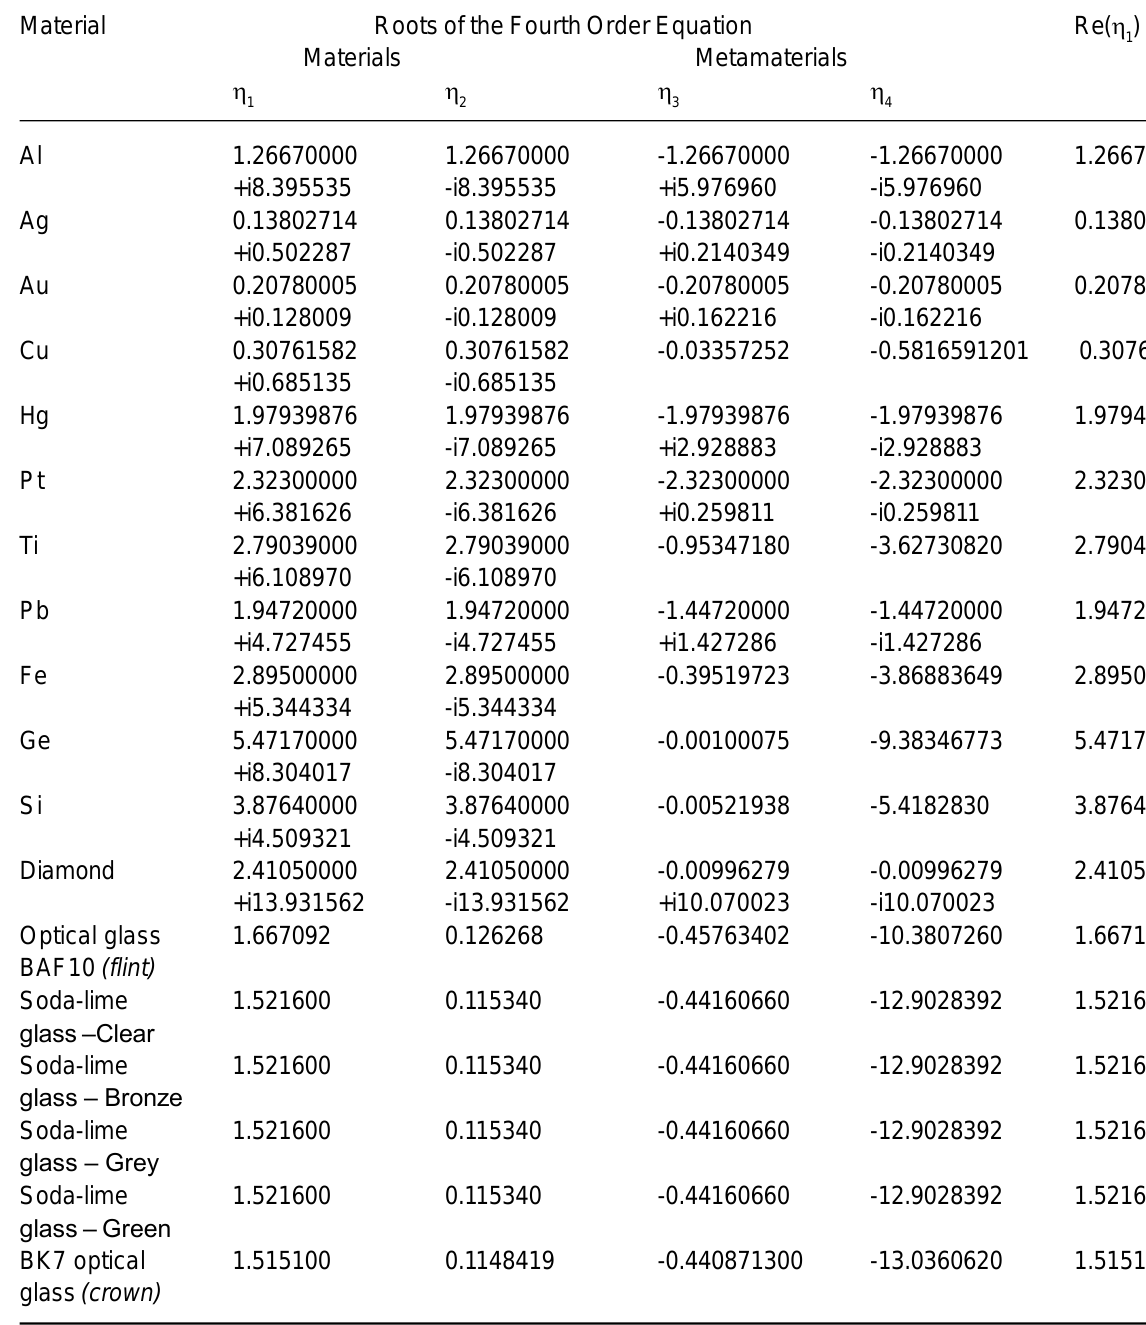
Table 2. Table values for materials and roots of the Fourth Order Equation and real part of 